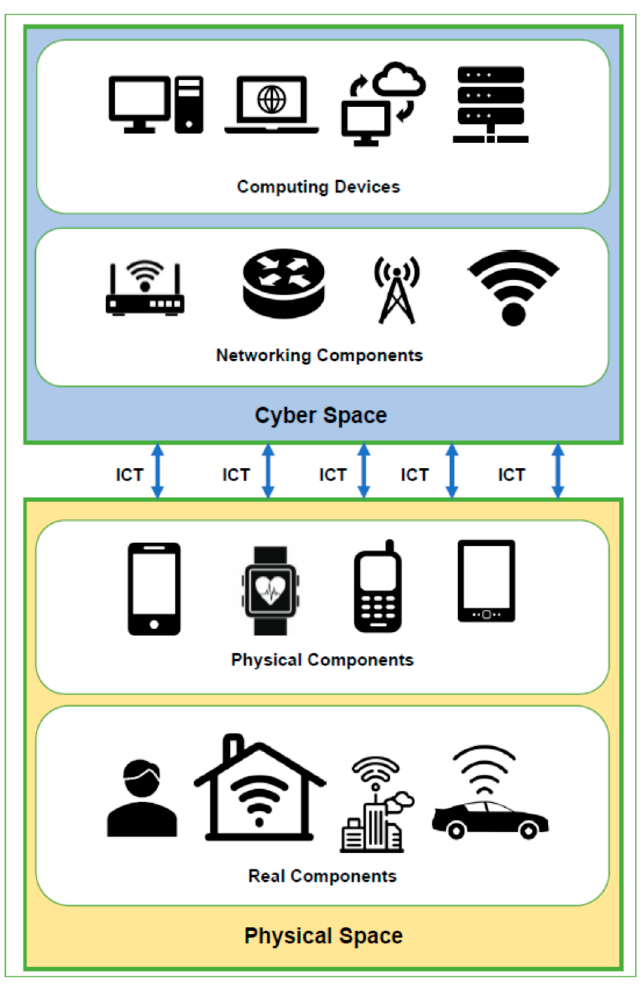
Figure 4. A typical CPS Diagram [45].